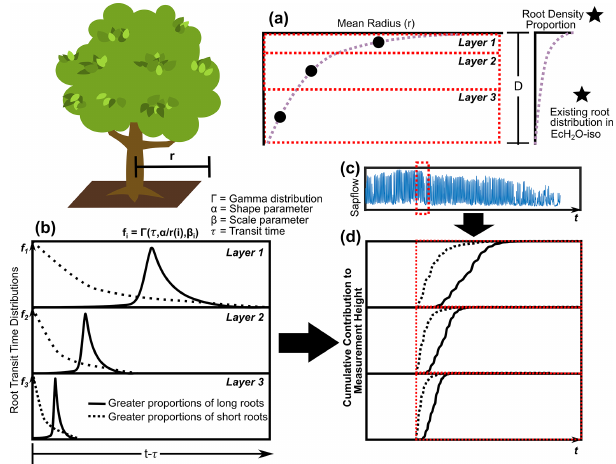
Figure 2. The estimation of rooting density (a) vertically and (b) the transit time distribution describing root velocity and distance to measurement height weighted by (c) sap flow to get the (d) cumu- lative contribution of soil water from entry time (red